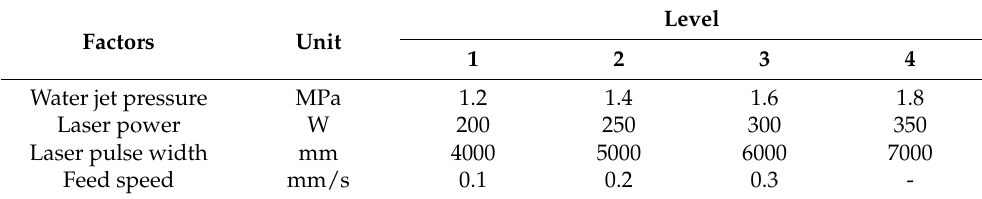
Table 2. Taguchi orthogonal experiment factor and level table.